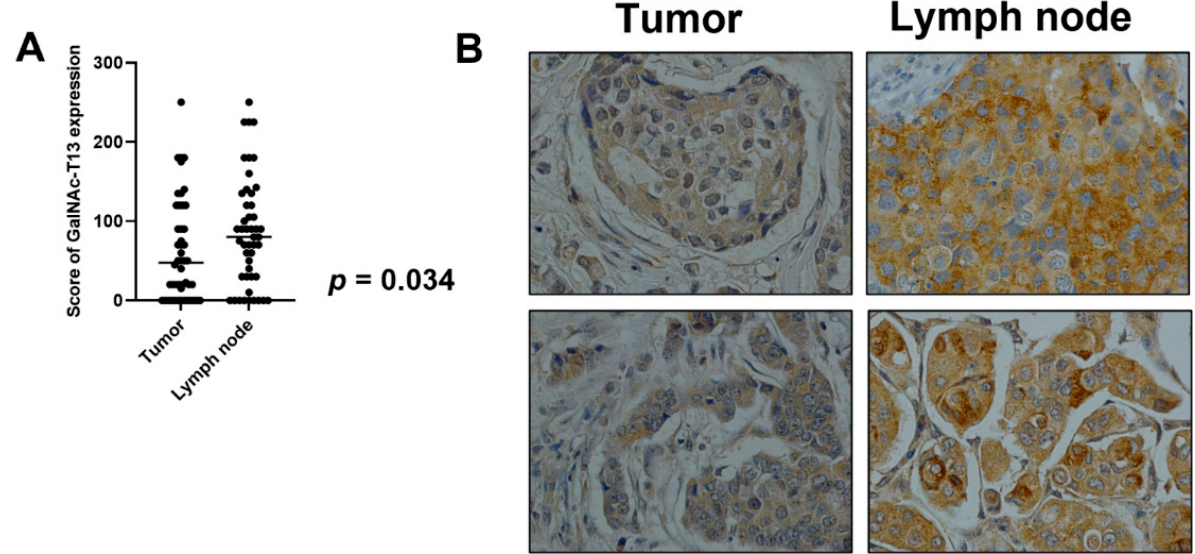
Figure 5. GalNAc-T13 expression in primary breast tumors and lymph node metastasis. ( A ) Comparison of mean expression of GalNAc-T13 by primary tumors and metastatic lymph nodes ( p = 0.034). ( B ) GalNAc-T13 immunostaining in primary tumors and corresponding lymph node metastasis (400 × magnification).